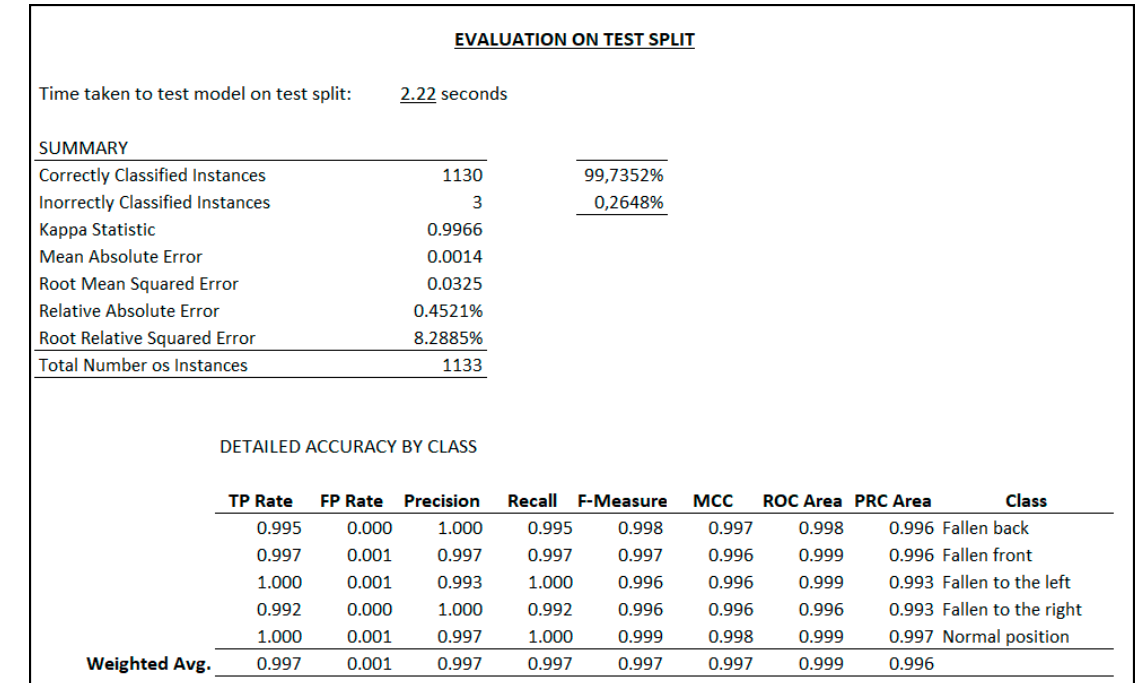
Figure 10. Statistical and precision analysis of the model .